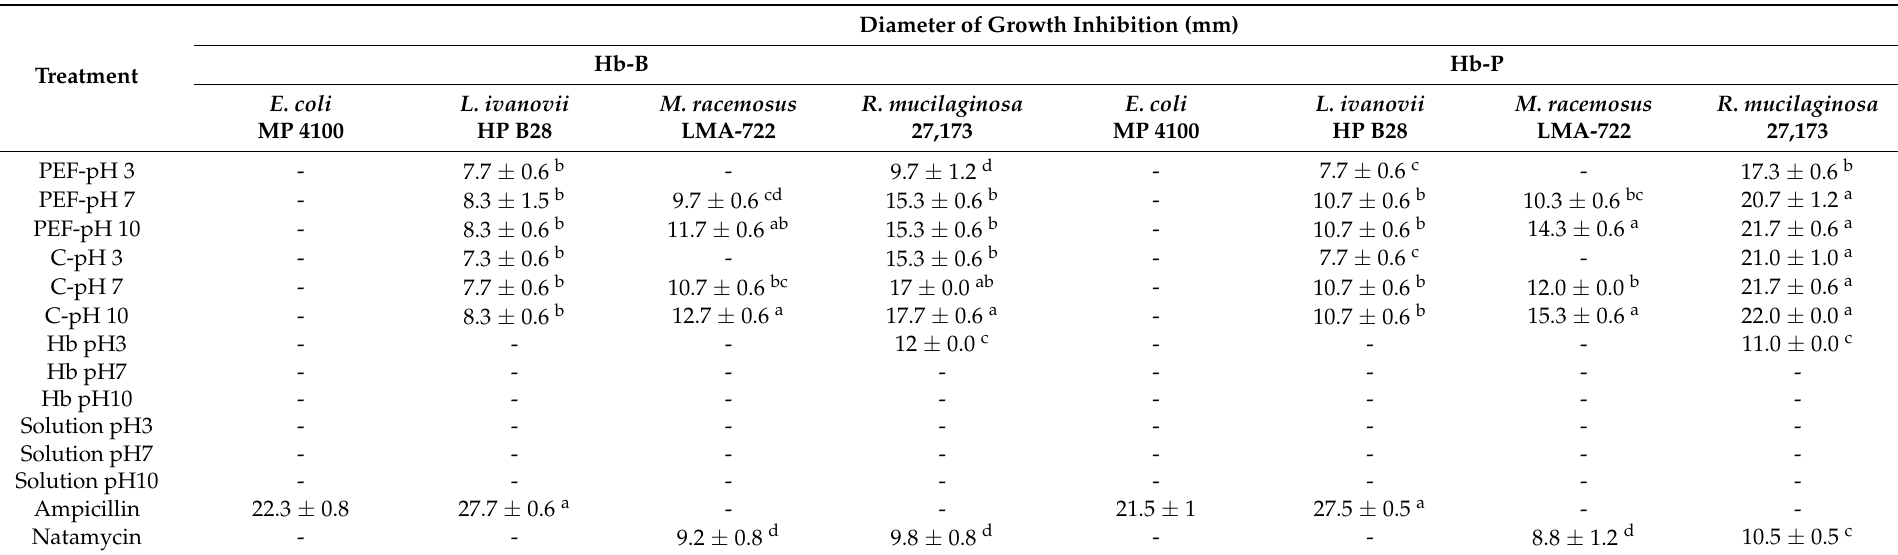
Table 1. Antimicrobial activity of Hb-B or Hb-P hydrolysates (40 mg/mL) at different pH values (3, 7, and 10) produced by pepsin after 3 h of hydrolysis.